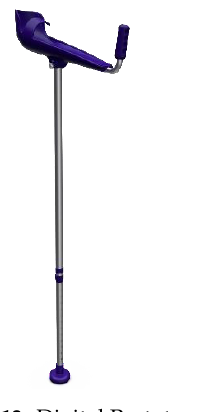
Figure 13. Digital Figure 13. Digital Prototype.